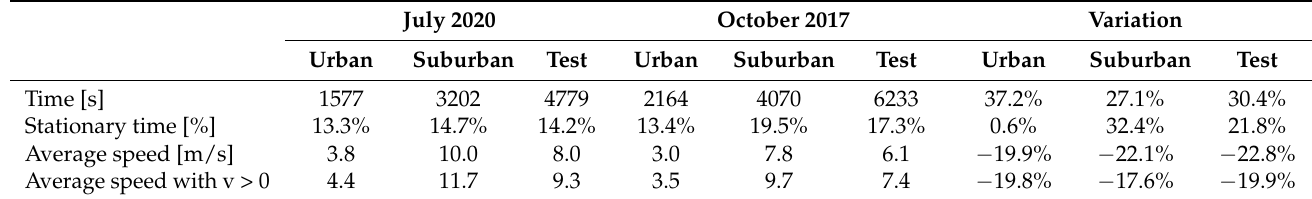
Table 6. Comparison between parameters of the 2017–2020